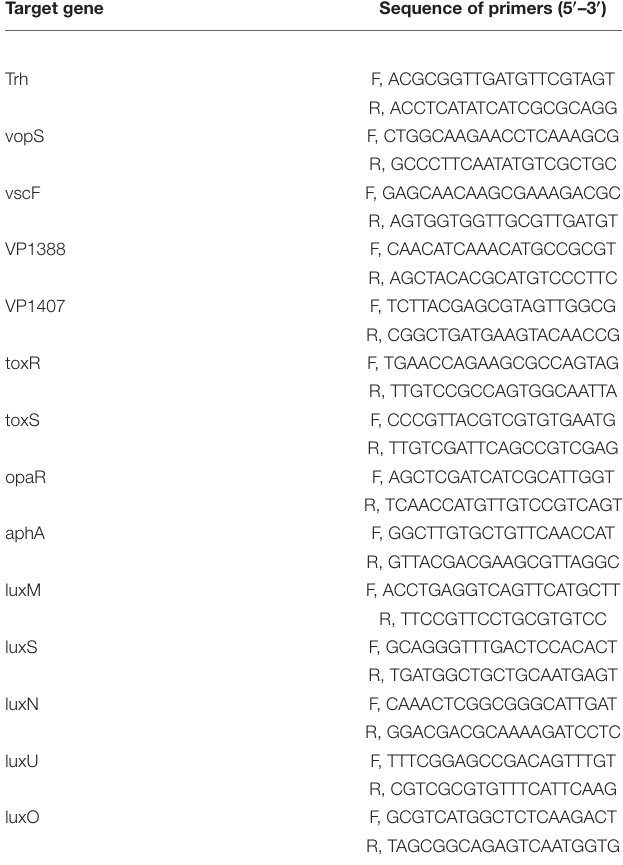
the influence of V. parahaemolyticus growth in the existence of levels (0.25 × , 0.5 × , 1 × , 2 × MIC and 5% Tween-80) were plotted. In Figure 1 , there was no obvious difference between the growth value of 5% Tween-80 and CK. This result was consistent with Orafidiya et al. (2001) and illustrated 5% Tween-80 was not antimicrobial to V. parahaemolyticus (Rizvi et al., 2013). The increase of V. parahaemolyticus was inhibited with different concentrations of MOEO and the effect was a dose-dependent and time-dependent manner. This result was consistent with Chen et al. (2021). There was no obvious difference between the growth value of 1 × MIC and 2 × MIC, and the growth of V. parahaemolyticus was completely